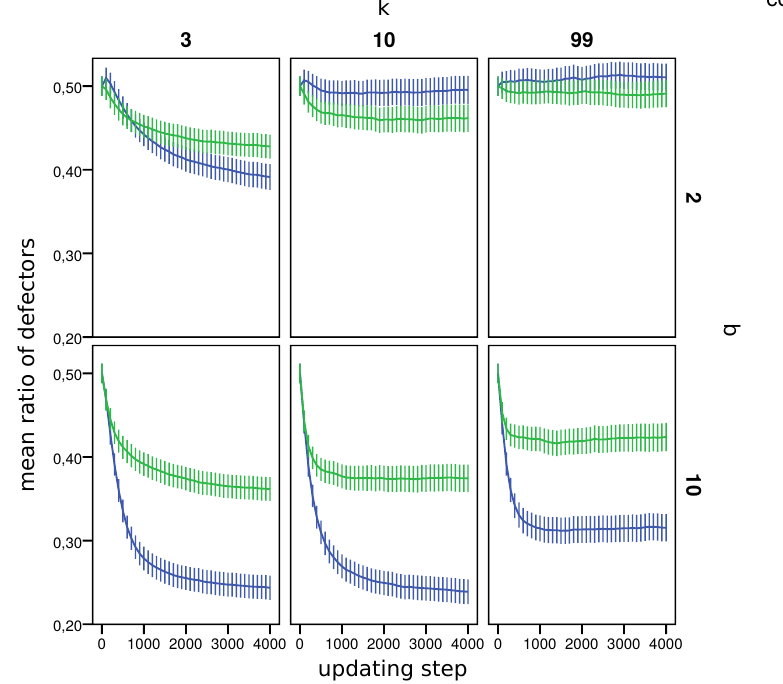
Figure 1. Ratio of defectors in worlds with different values for k and b (bars indicate 95%-confidence intervals). To identify the parameters that had the largest effect on the ratio of defectors in worlds with and without UCs, we used a step-wise regression builder (based on the AIC). The regression